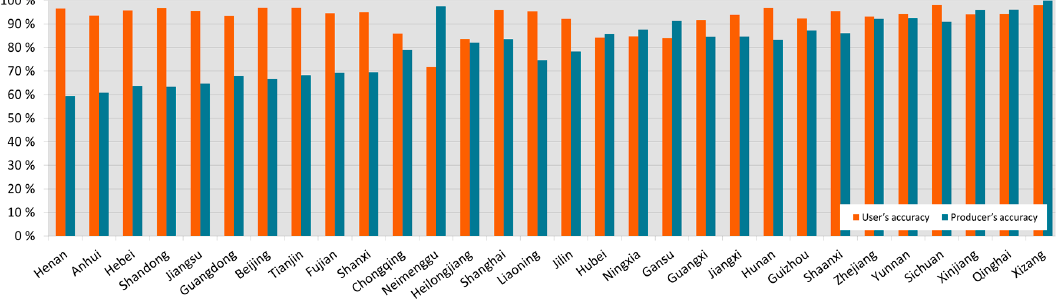
Figure 6. The user’s and producer’s accuracy of 30 provinces in ascending order of the kappa coefficient.